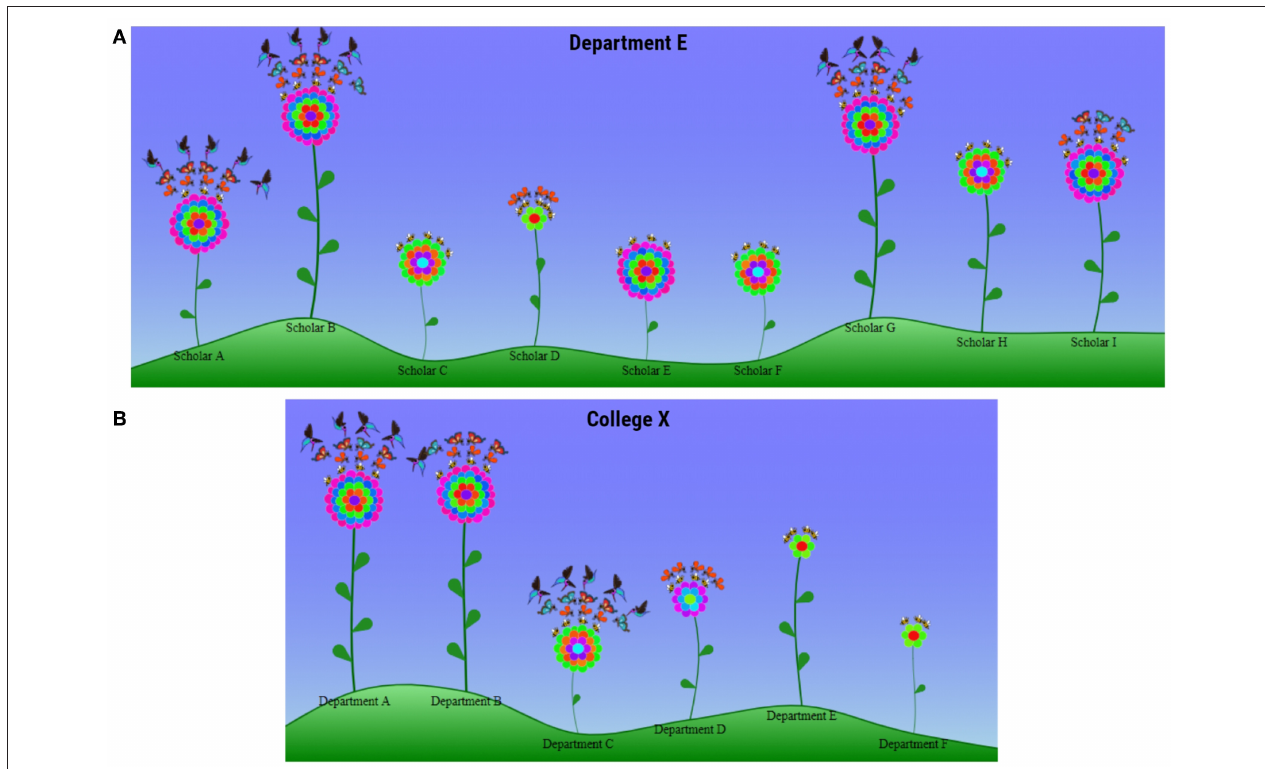
FIGURE 3 | Iconic form of SP. (A) Individual faculty of “Department E.” (B) Departments of “College X.” Placement of the flowers on the rolling landscape is largely random, to support naturalness; so is the number of pollinators in each